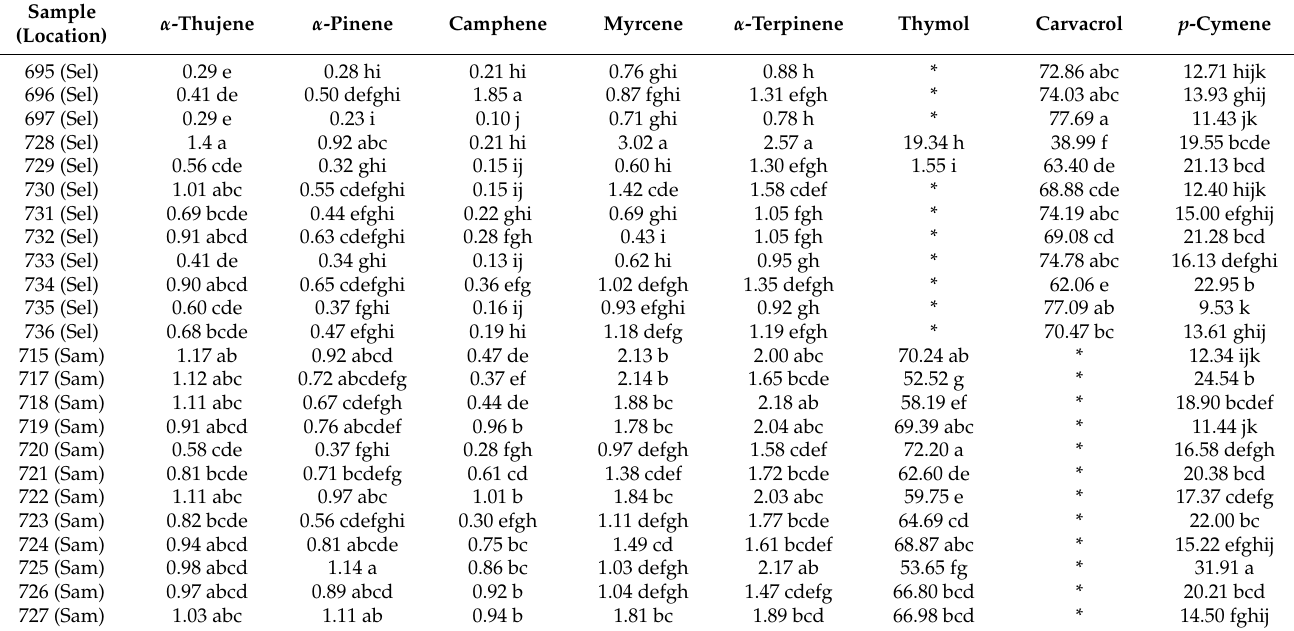
Table 5. Mean concentration (%) of α -thujene, α -pinene, camphene, myrcene, α -terpinene, thymol, carvacrol, and p -cymene of S. pilosa obtained from 24 samples collected at the 2 locations (Sel = Selce, Sam = Samokitka).